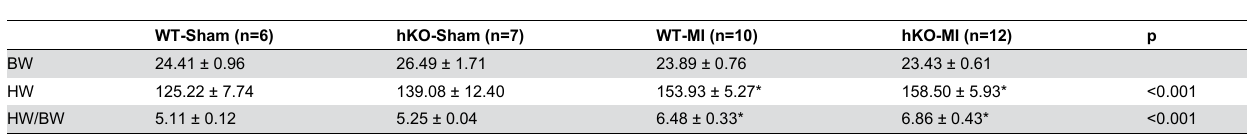
Table 1. Morphometric Measurements.